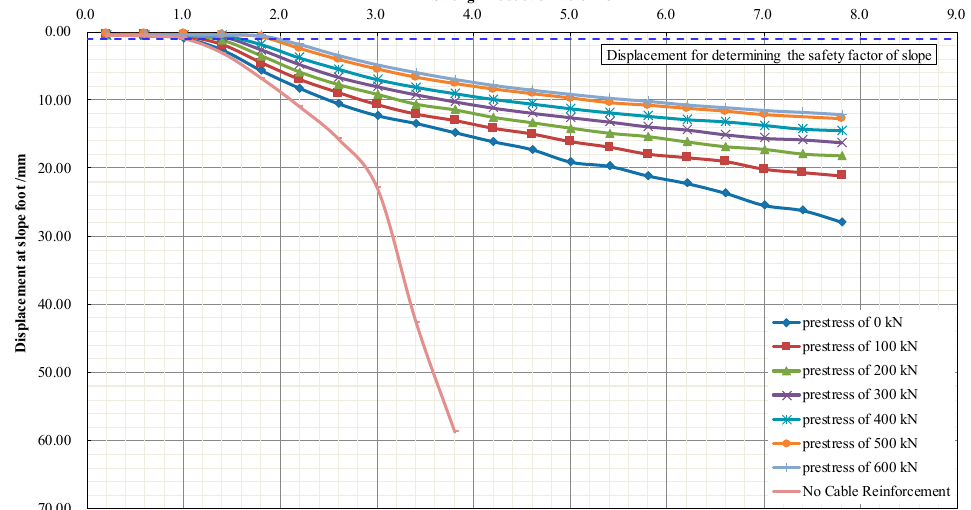
Figure 6. The relationship between the displacement of the slope foot and the strength reduction factor.